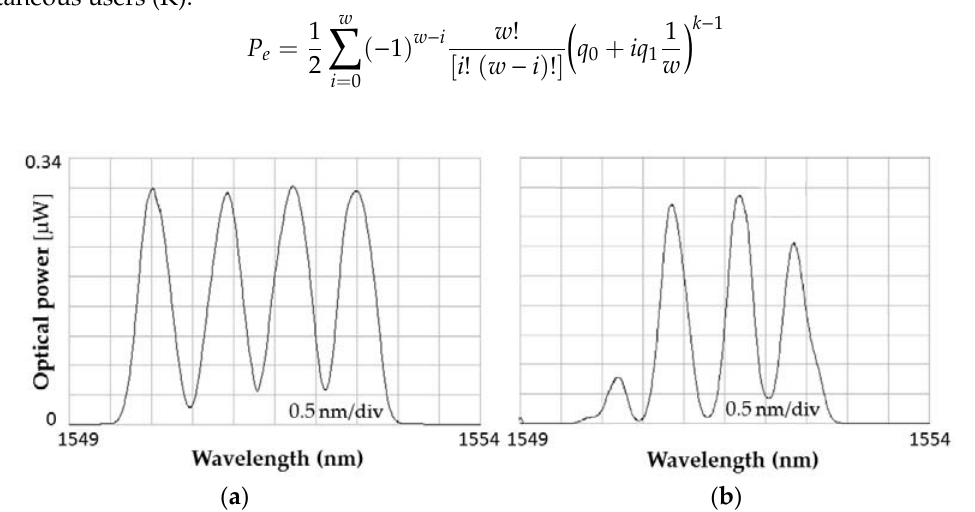
Figure 7. Impact of SOA on 2D-WH / TS code based on four-wavelength code carriers as recorded by an optical spectrum analyser: ( a ) without and ( b ) with the SOA present in the chromatic-dispersion (CD) compensated transmission link.